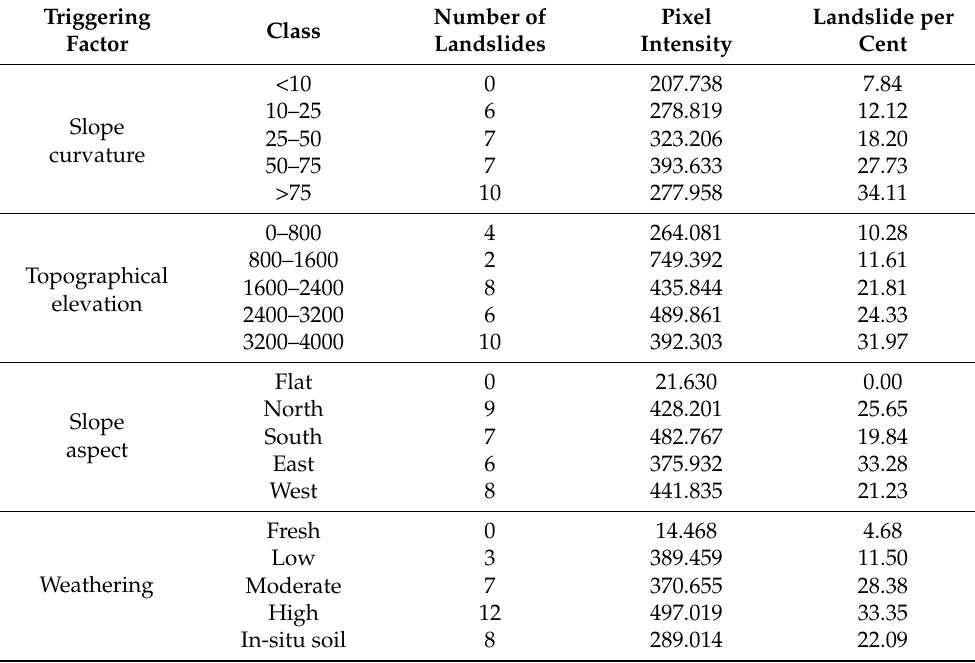
Figure 8. Basic map of the CNN-based susceptibility analysis.